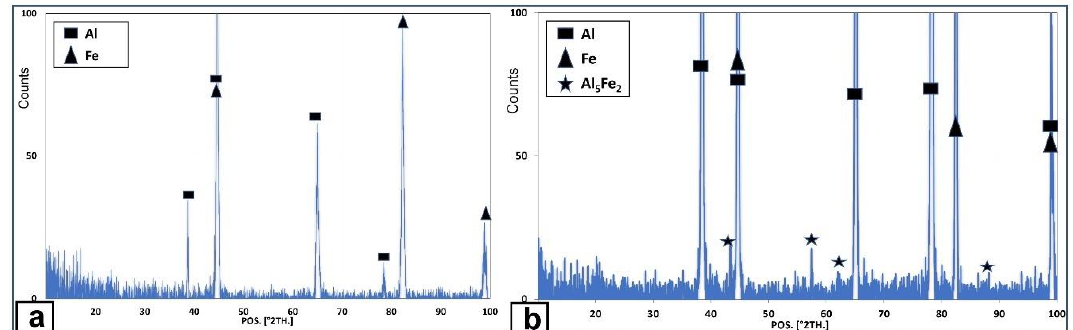
Figure 11. XRD analysis of the aluminum/steel interface produced with FSP tool pin length of 3.2 mm and rotation speed of ( a ) 500 rpm and ( b ) 1500 rpm.